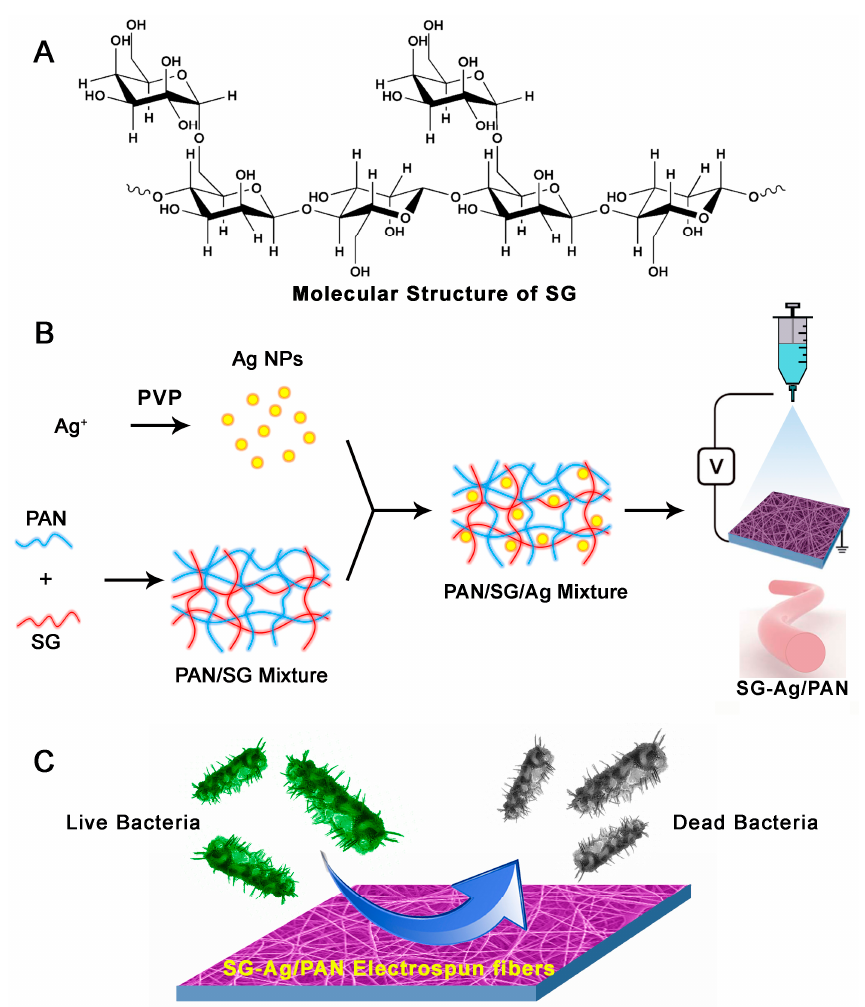
Figure 1. ( A ) Molecular structure of sesbania gum (SG). ( B ) Schematic illustration of SG-Ag/PAN electrospun fiber synthesis using electrospinning. ( C ) Schematic depiction of the antibacterial action of SG-Ag/PAN electrospun fibers against bacteria.